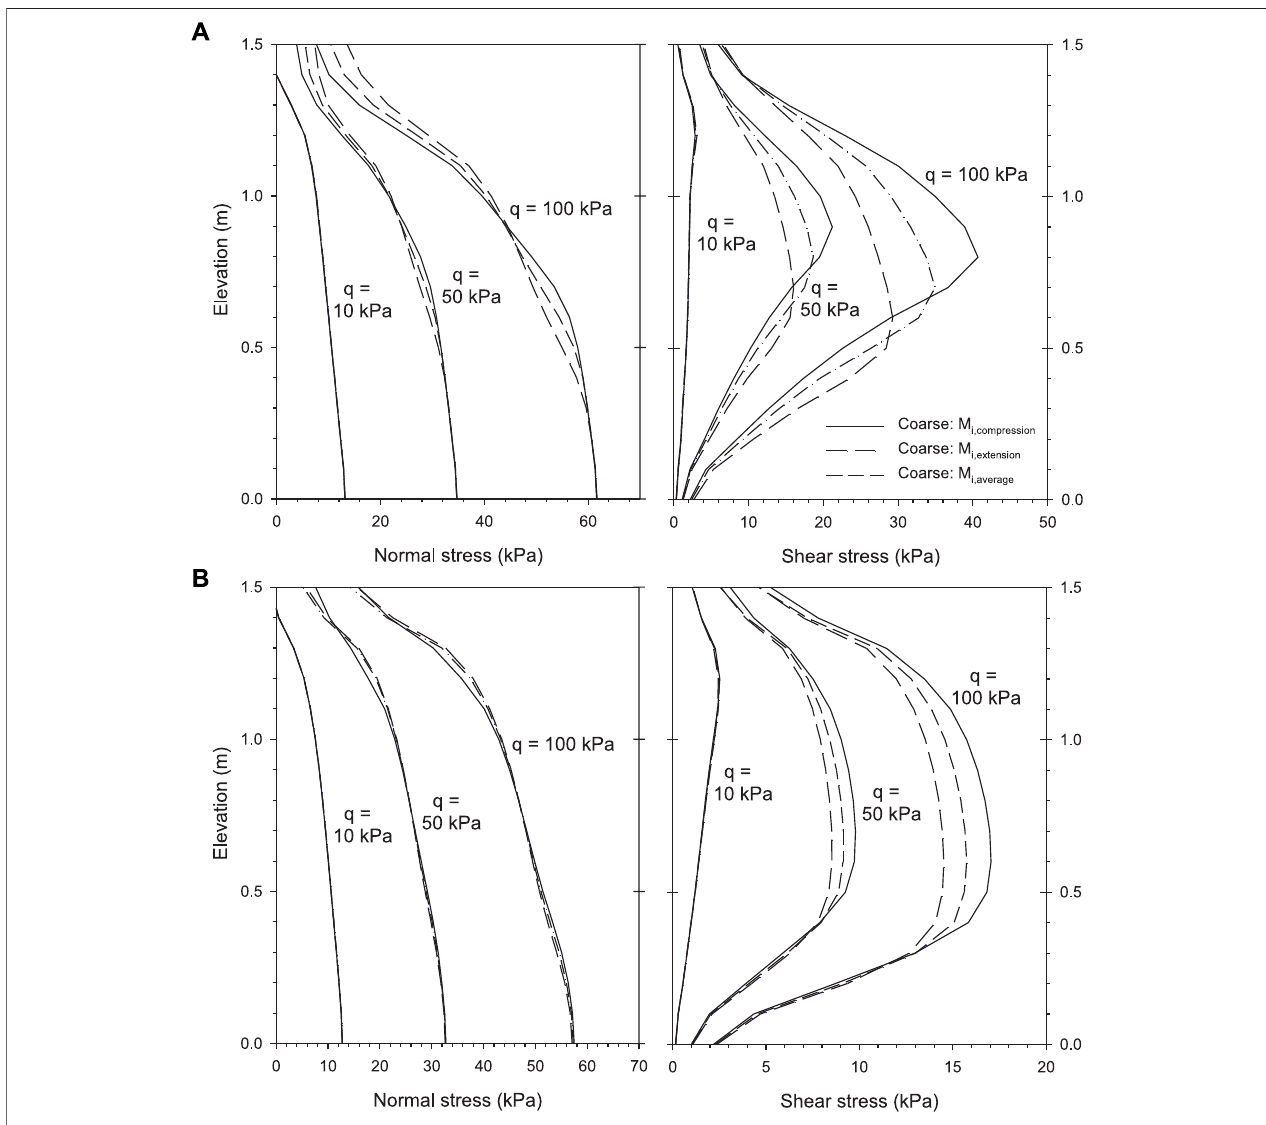
FIGURE 10 | Load transfer from back fi ll soil to facing panel using program CODE_BRIGHT: normal and shear stresses with different Mi parameter ( M compression ‒ default assumed case — compared with M extension and M average ). Cases with: (A) Ri = 0.8 and (B) Ri = 0.3.